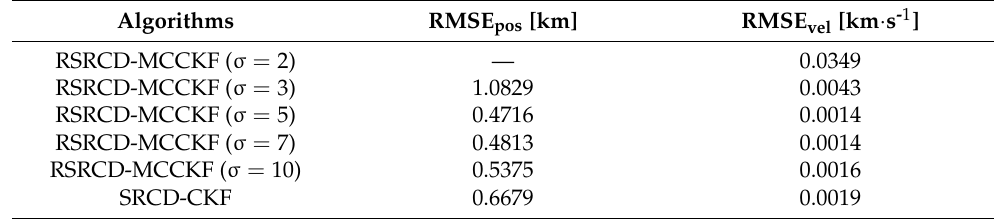
Table 2. Algorithm accuracy under non-Gaussian noise when kernel bandwidth is different.